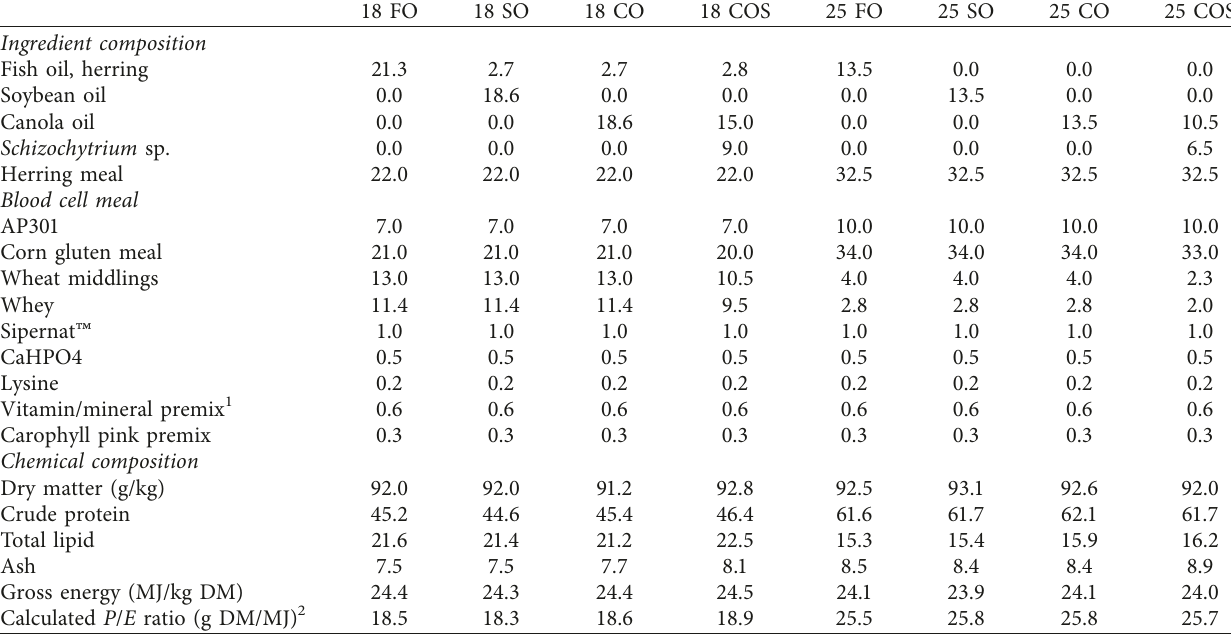
Table 1: Feed components and chemical composition of experimental diets (g/kg dry